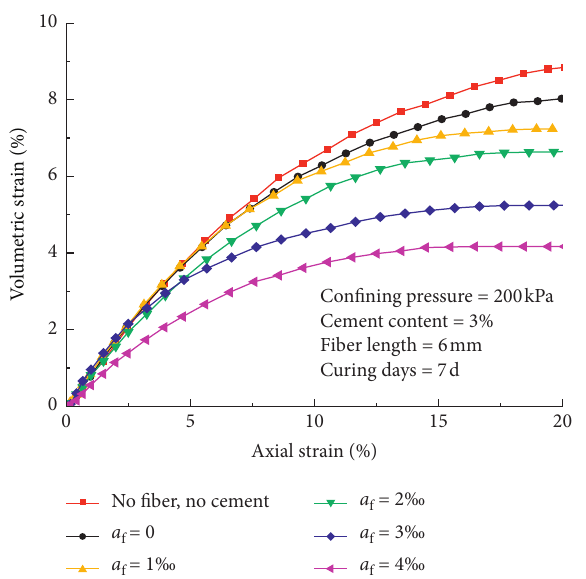
Figure 9: Strength enhancement under different fiber contents.